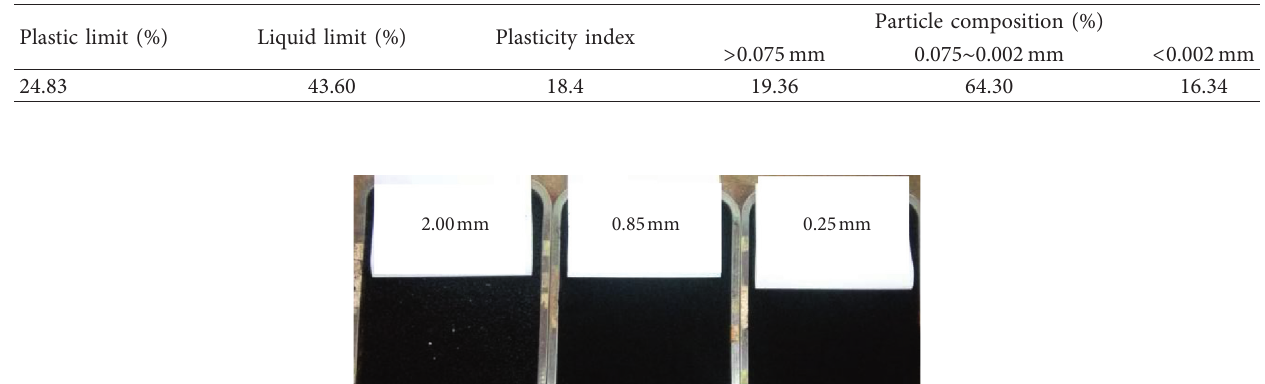
Table 1: Basic physical indicators of red clay.